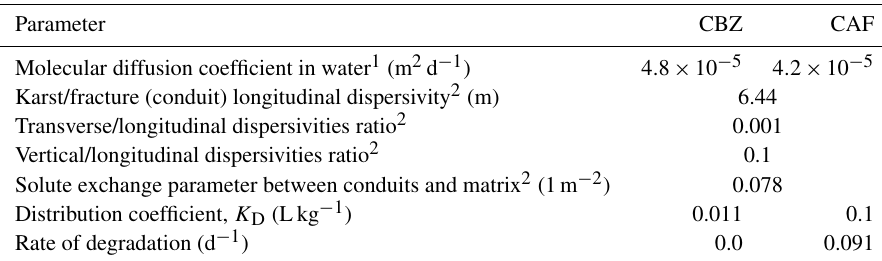
Table 2. Transport model parameters.